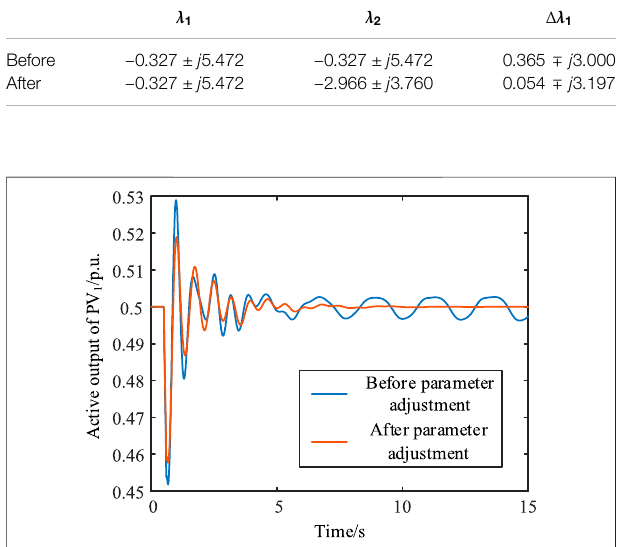
FIGURE 14 | Non-linear simulation results of the active power output of PV 1 before and after parameter